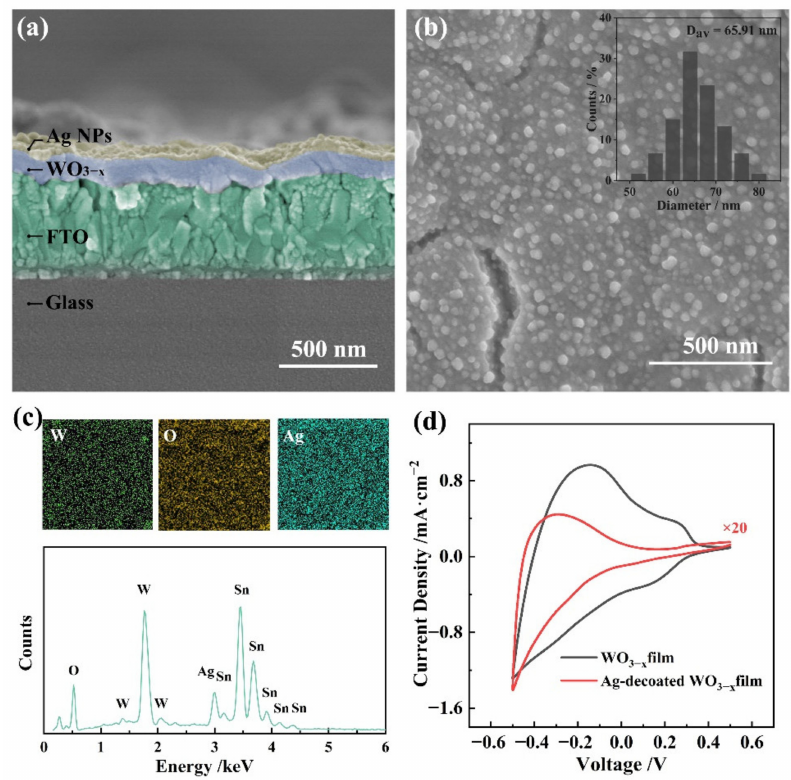
Figure 1. ( a ) Cross-sectional and ( b ) top view SEM images of Ag-WO 3 − x film on FTO glass syn- thesized with an applied potential of − 0.6 V. ( c ) Elemental mapping images and EDS profiles of Ag-WO 3 − x film. ( d ) CV curves of WO 3 − x film and Ag-WO 3 − x film in 0.1 M H 2 SO 4 at a scan rate of 50 mV · s − 1